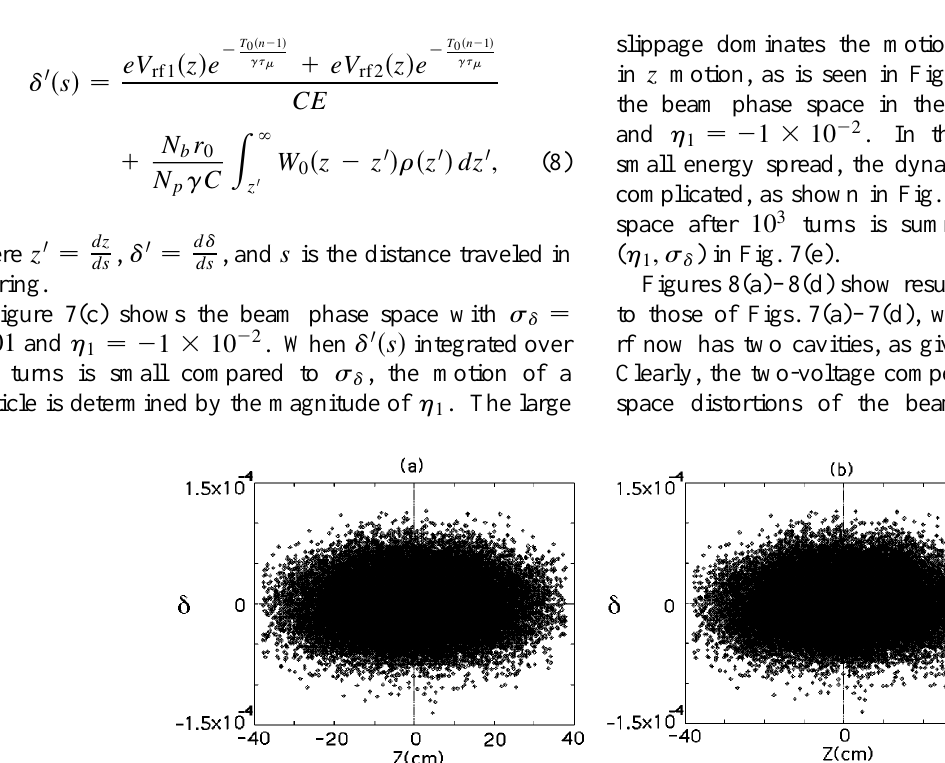
FIG. 6. The longitudinal beam phase space for two values of the beam pipe radius 3.0 cm in (a) and 1.76 cm in (b). The resulting resonant frequency (cid:119) (cid:114) of the broadband impedance in (a) and (b) is 10 and 16.9 GHz, respectively. With appropriate adjustment of the two rf cavities, the compensation scheme is seen to work. In both figures, s d (cid:173) (cid:51) 3 (cid:49)(cid:48) 2 (cid:53) , h (cid:49) (cid:173) 2 (cid:49) 3 (cid:49)(cid:48) 2 (cid:54) , jj j (cid:173) (cid:48)(cid:46)(cid:49) V and j (cid:90) (cid:110) (cid:104)